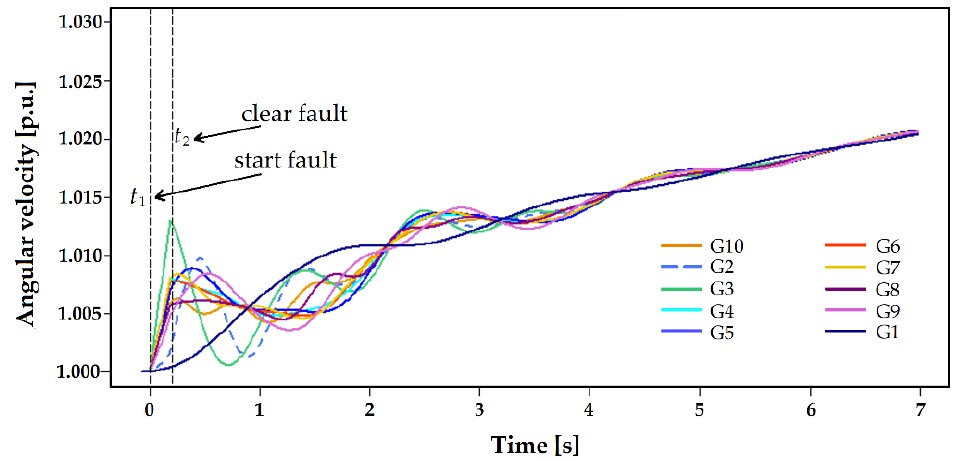
Figure 9. Rotor speed of the generator in a critical stable case.